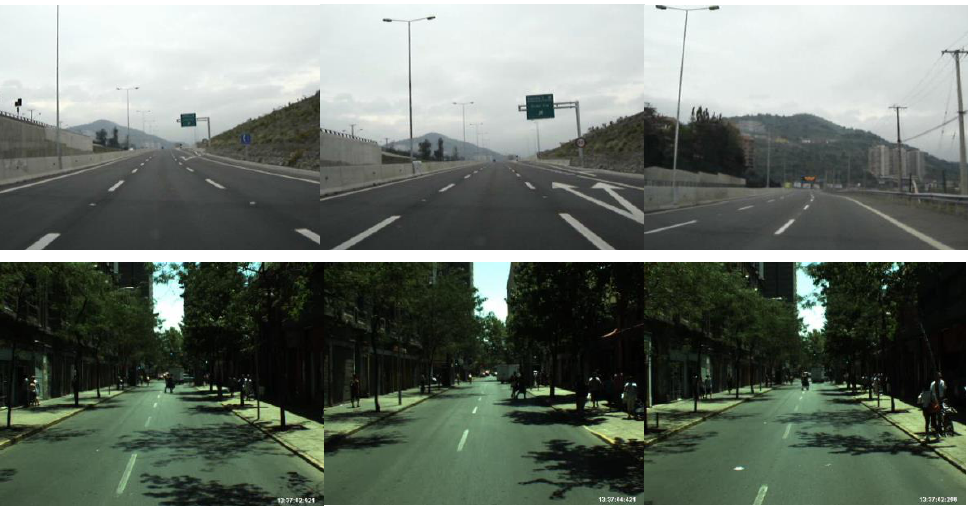
Figure 18. Examples of the SLD dataset.